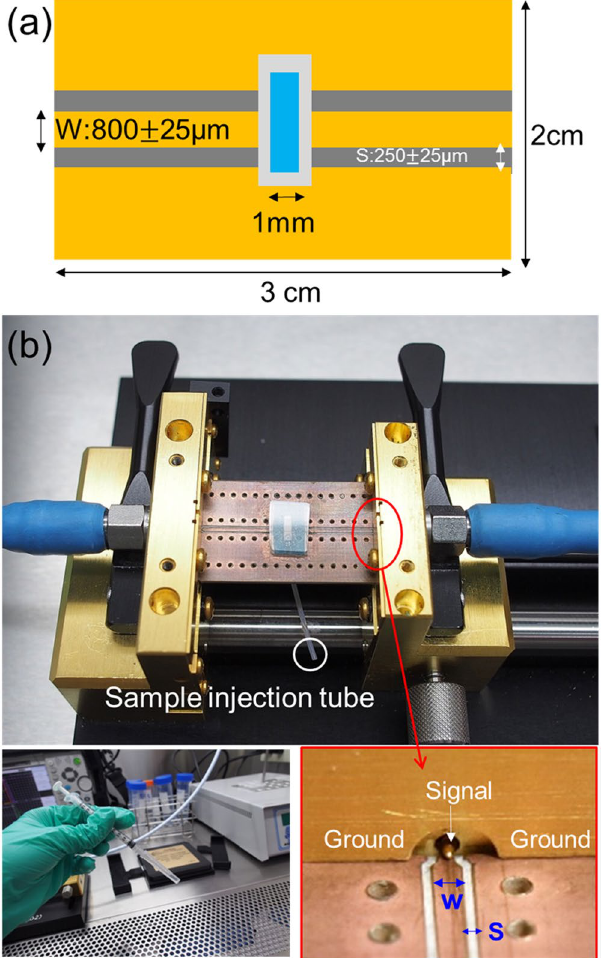
Figure 4. Microwave absorption spectrum measurement. ( a ) Schematic top view of a microfluidic channel sticking on top of a coplanar waveguide (CPW). ( b ) Photos showing the microfuidic channel integrated CPW on the test fixture, the 1 ml syringe, and details regarding the contact between CPW and test